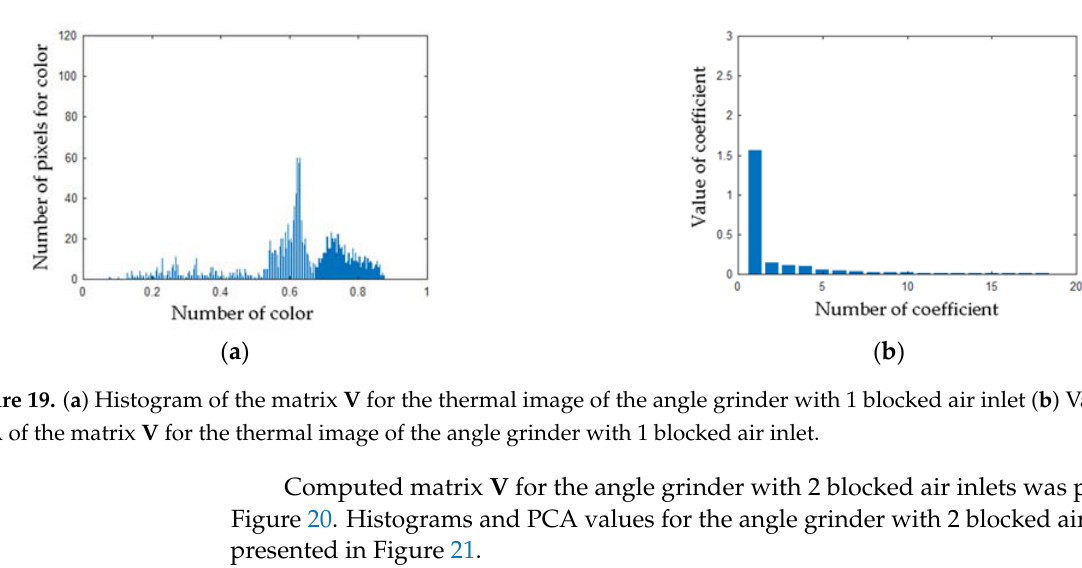
Figure 18. Values of the matrix V for the thermal image of the angle grinder with 1 blocked air inlet (indicated by the green line).